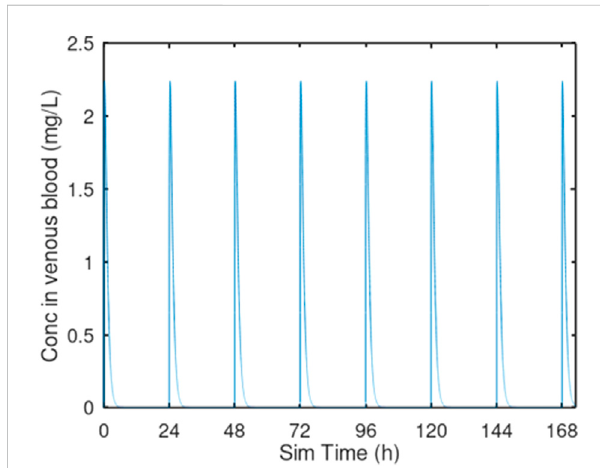
FIGURE 2 Oral gavage dosing. Predicted venous blood concentration for